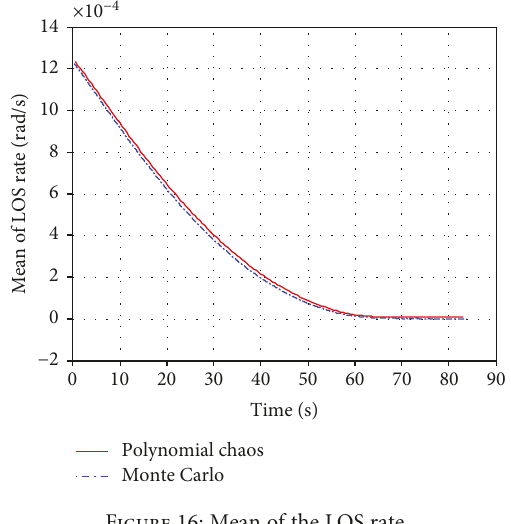
Figure 16: Mean of the LOS rate.